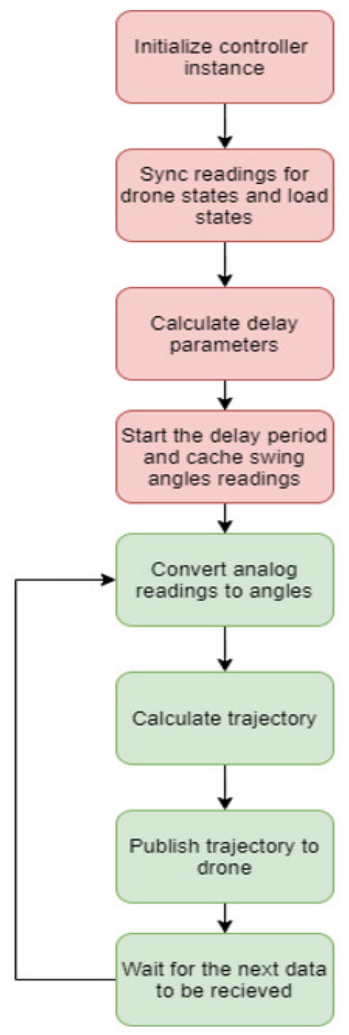
Figure 14. Trajectory plotter.